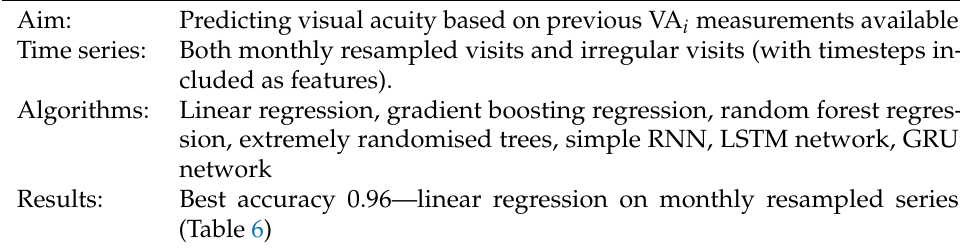
Table 3. Experiment : Forecasting VA t + 1 from previous VA data. 1